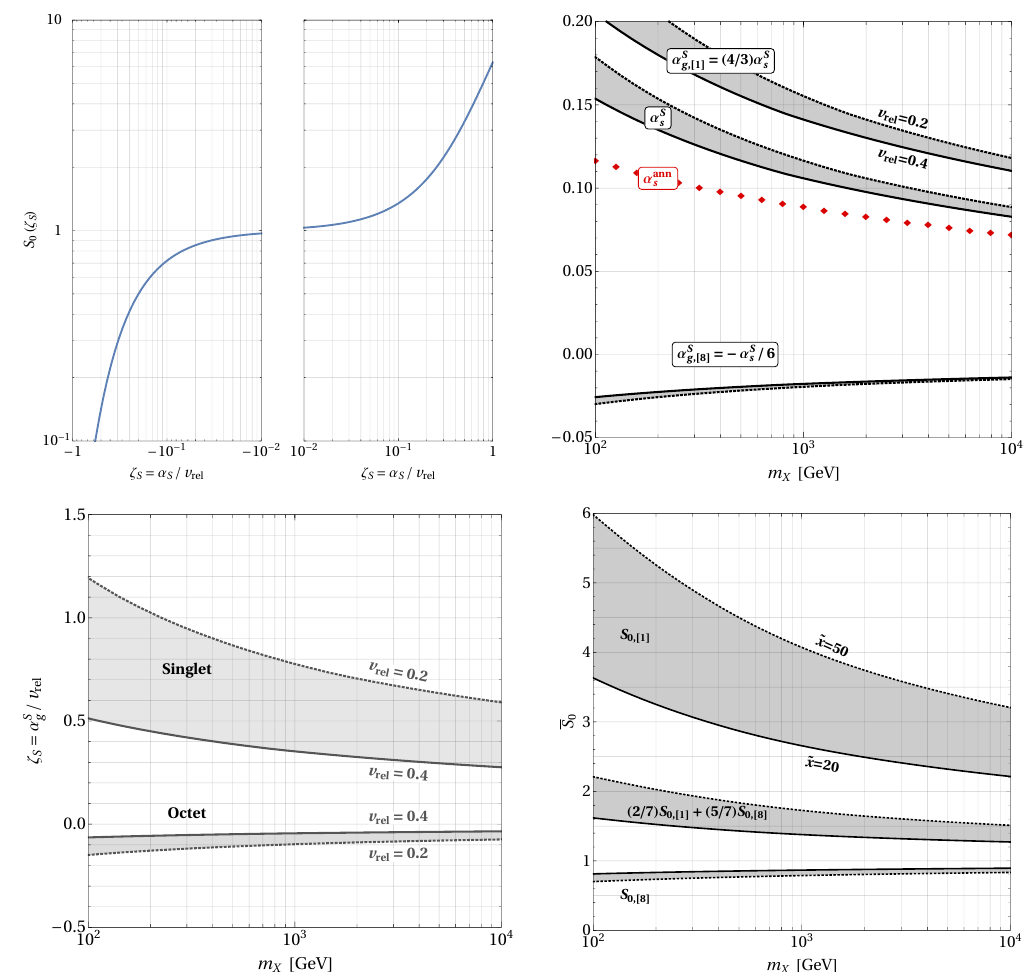
Figure 3. Top left: the Sommerfeld factor for s -wave annihilation, S 0 ( (cid:16) ), vs (cid:16) (cid:17) (cid:11) S =v rel , for both g S S attractive ( (cid:16) > 0) and repulsive ( (cid:16) < 0) Coulomb interaction. Top right: the running of (cid:11) s in the S S scattering states, where the average momentum exchange is Q = ( m = 2) v rel . For the colour-singlet X and the colour-octet states, (cid:11) S = (4 = 3) (cid:11) S and (cid:11) S = (cid:0) (cid:11) S = 6. We show (cid:11) S , (cid:11) S and (cid:11) S in the g; [ 1 ] s g; [ 8 ] s s g; [ 1 ] g; [ 8 ] velocity range 0 : 2 < v rel < 0 : 4, that is typical during the DM freeze-out. For comparison, we also show the strong coupling at the gluon emission vertices of the annihilation processes, (cid:11) ann , which s corresponds to Q = m ( red diamonds ). Bottom left: the parameter (cid:16) = (cid:11) S =v rel that determines g X S the Sommerfeld e(cid:11)ect. Bottom right: the thermally-averaged s -wave Sommerfeld factor, (cid:22) S 0 , for ~ x (cid:17) m =T within the indicative range 20 < ~ x < 50 during which the DM abundance freezes-out. X Using d = 3, C ( 3 ) = 1 = 2, C ( 3 ) = 4 = 3 and C ( G ) = 3, and setting (cid:17) = (cid:17) = 1 = 2 2 2 1 2 R